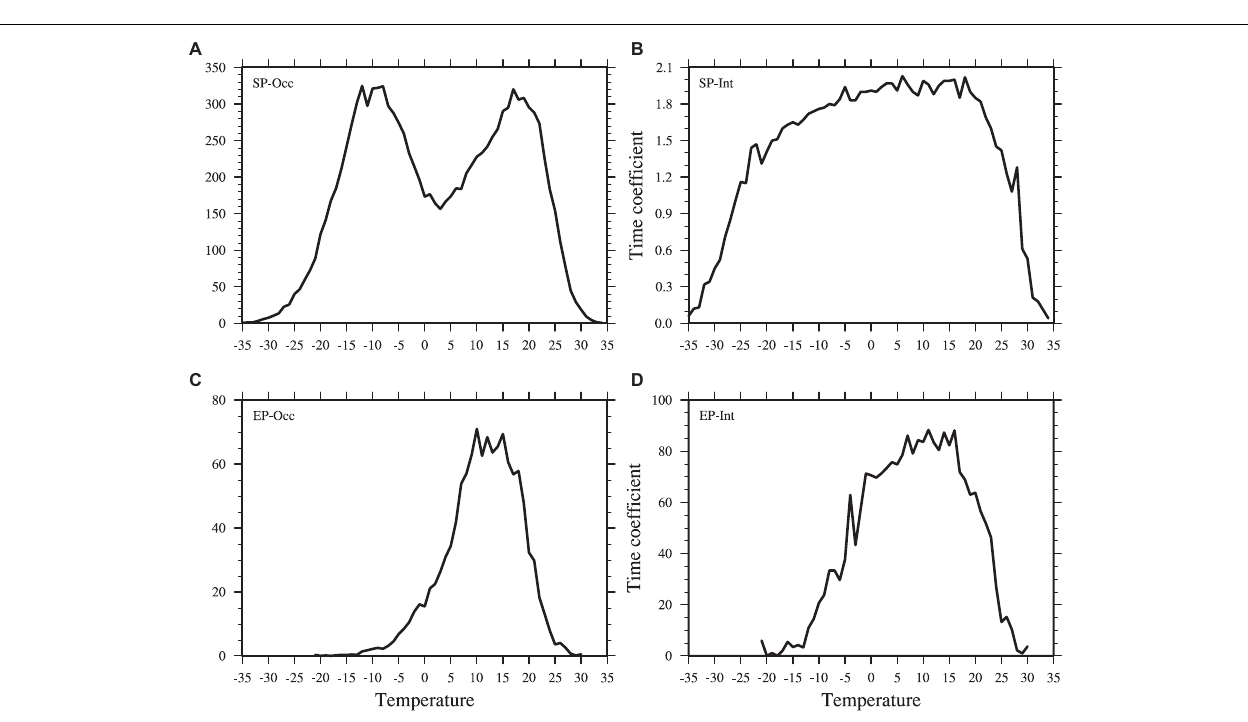
FIGURE 8 | The first eigenvectors from the EOF analysis of variations in (A) SP event frequency, (B) SP event intensity, (C) EP event frequency, and (D) EP event intensity with daily mean temperature change.